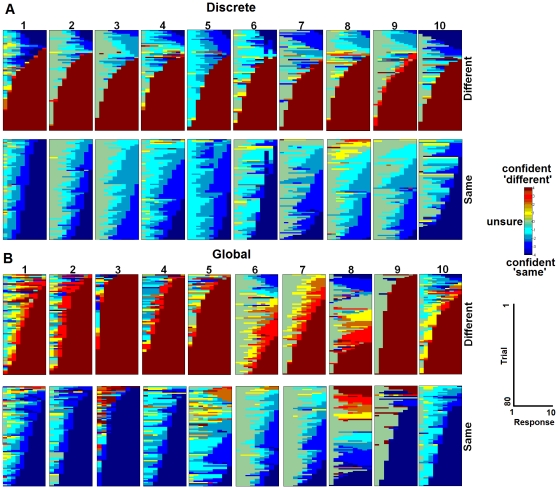
Tracking perceiving and knowing over time.Same/different confidence responses across repetitions for each trial in the flicker paradigm. Data are shown for the ten individuals (numbers on top of each column of blocks) tested in the discrete change condition (A) and the ten individuals tested in the global change condition (B). ‘Different’ trials are the top row of blocks for each of the discrete and global change conditions; ‘same’ trials are the bottom row of blocks for each condition. Trials are sorted so that the fastest learning trials appear on the bottom of each block. In each block, every row is a trial, and the x-axis represents responses 1 through 10. Unsure responses are green, hotter colors indicate more confident ‘different’ responses; cooler colors indicate more confident ‘same’ responses. In the discrete change condition, the correct identification of differences showed an abrupt, step function transition to high confidence responses. In contrast, in the global change condition, the correct identification of differences showed step function transitions on some trials and more gradual transitions on other trials. The identification of sameness gradually transitioned from low to intermediate to high confidence for both conditions.